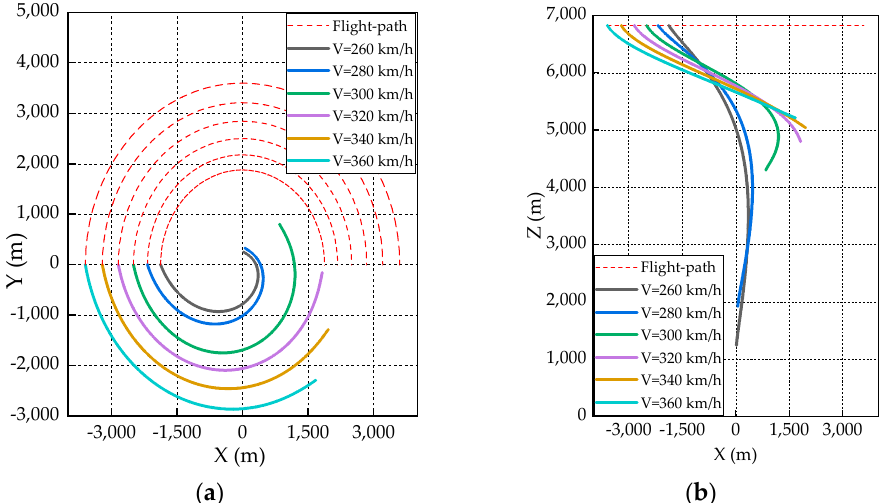
Figure 18. Towline spatial configurations vs. indicated rotational airspeed: ( a ) Two-dimensional projection in horizontal plane. ( b ) Two-dimensional projection in vertical plane.